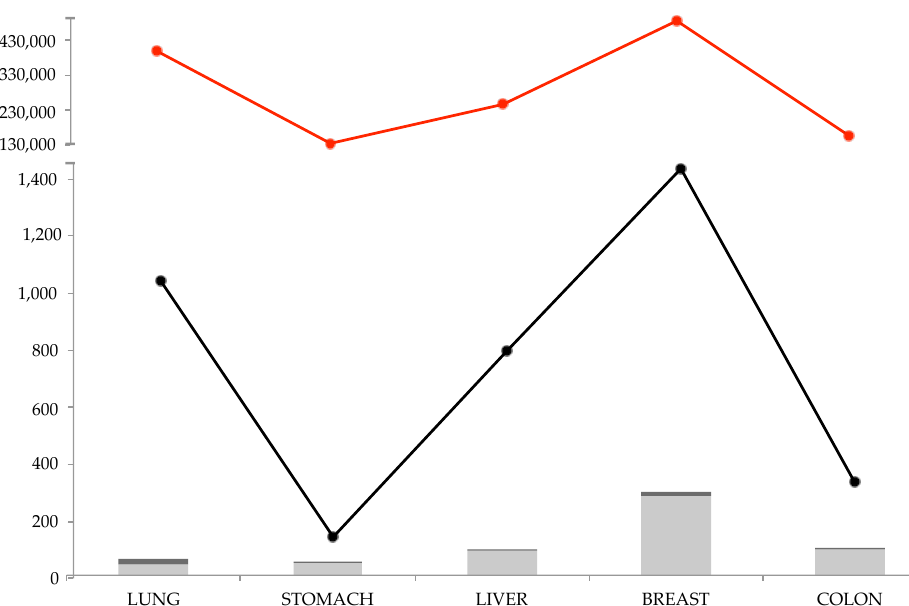
Figure 2. Total number of analyzed research papers. Red line: total number of papers for the corresponding cancer types. Black line: total number of papers for the corresponding cancer types and retinoic acids. Histograms: total number of research papers selected in the present review for relevancy of which: light gray, pre-clinical studies; dark gray, clinical